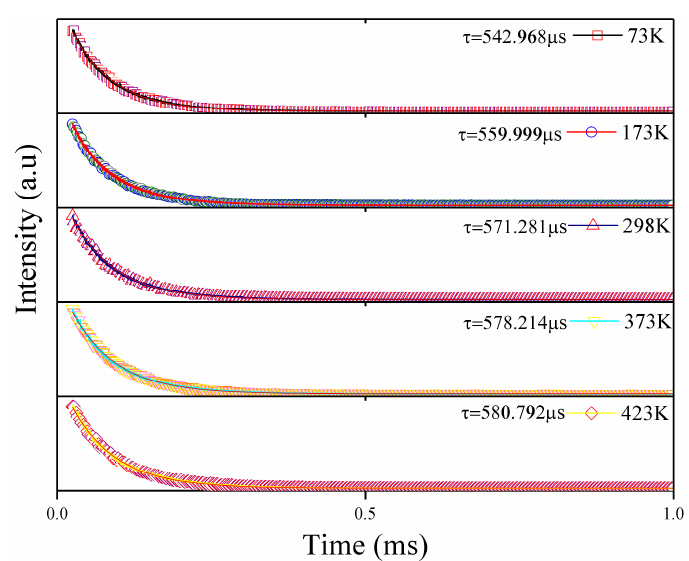
Figure 6. The fluorescence decay curves of the 4 G 5/2 → 6 H 9/2 transition in 1.0 mol.% Sm:LN single crystal at different temperatures.